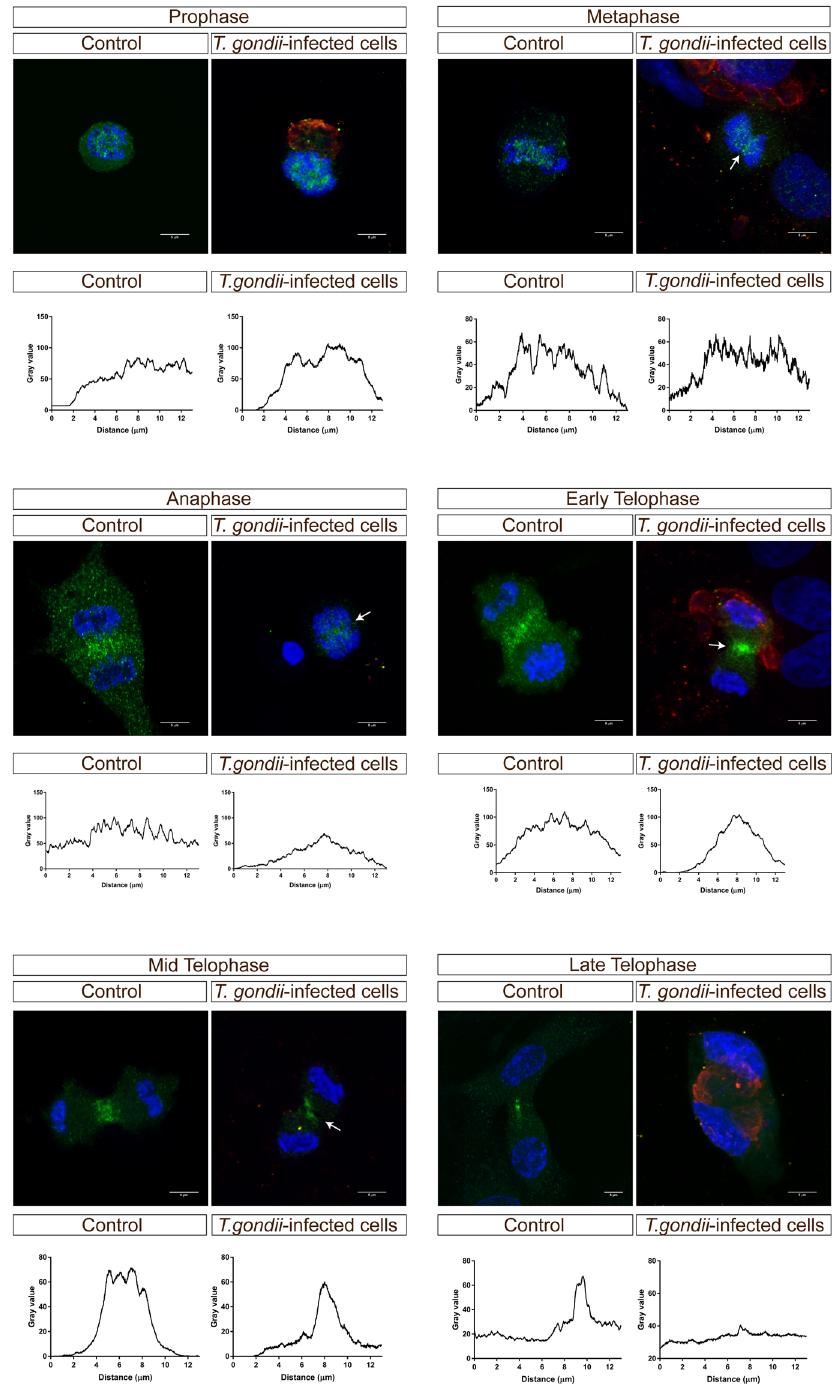
Figure 7. Aurora B expression in T. gondii –infected BUVEC. Mitotic T. gondii -infected BUVEC and control cells were stained for DNA via DAPI (blue), for T. gondii tachyzoites (red) and for Aurora B (green) and analyzed via confocal microscopy. To analyze the extension of Aurora B expression within the cell, we measured the intensity of Aurora B-related signals along a 13 µ m-line and plotted these data as a graph showing intensity value vs distance (in µ m). White arrows indicate Aurora B expression in T . gondii-infected cells. Scale bar represents 5 µ